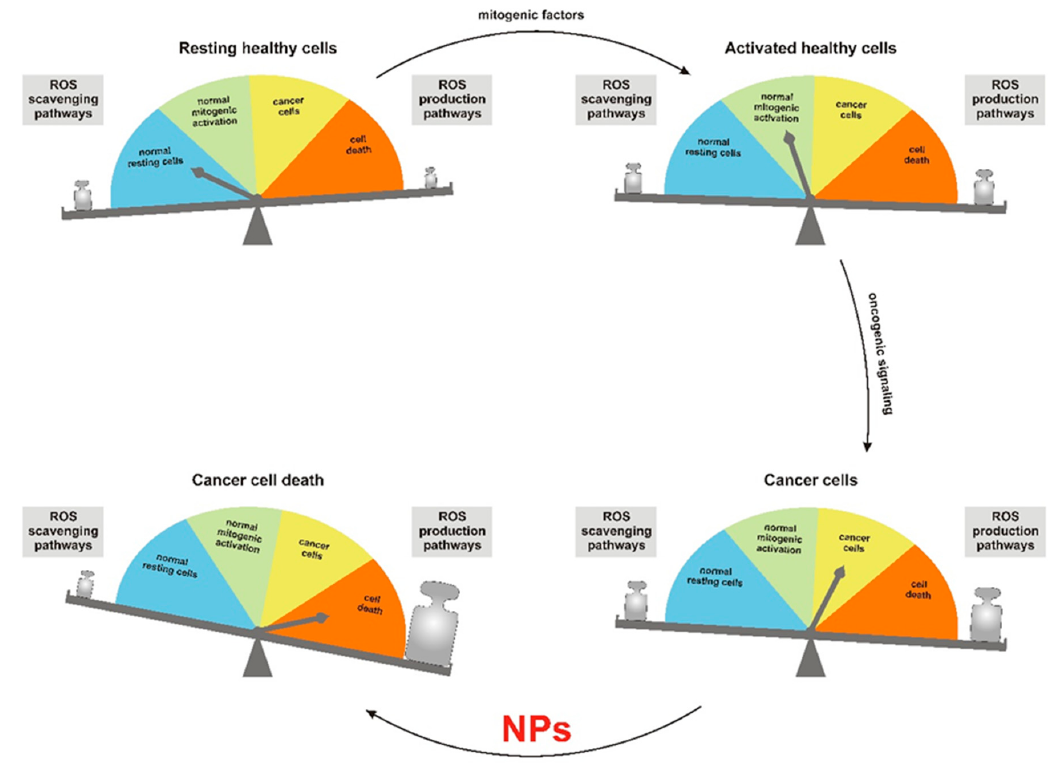
Figure 1. The reactive oxygen species (ROS) rheostat affects cell fate. NPs: nanoparticles.